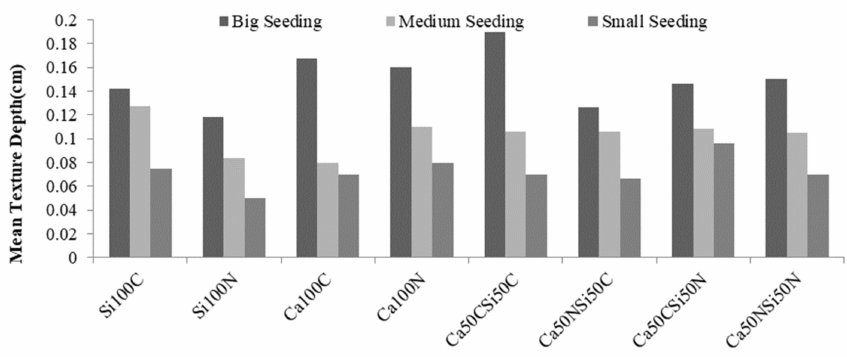
Figure 13. MTD in abrasive seeding macro-textures versus different mix proportions.